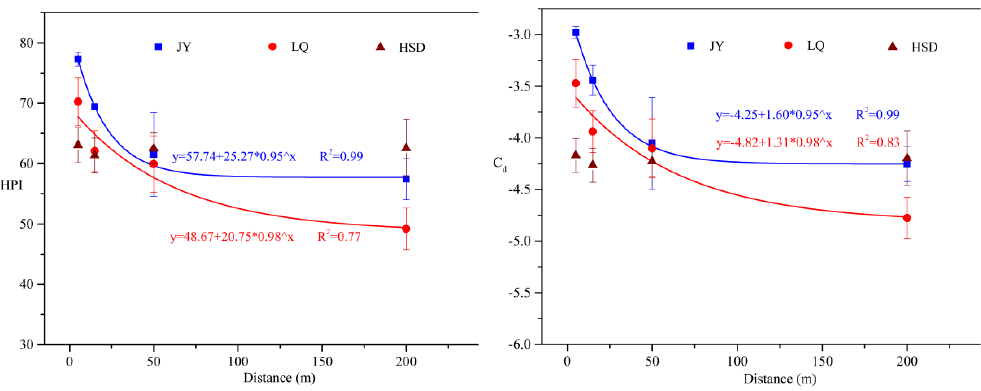
Figure 4. Relationship between HPI and C d values and distance to the highway edge.